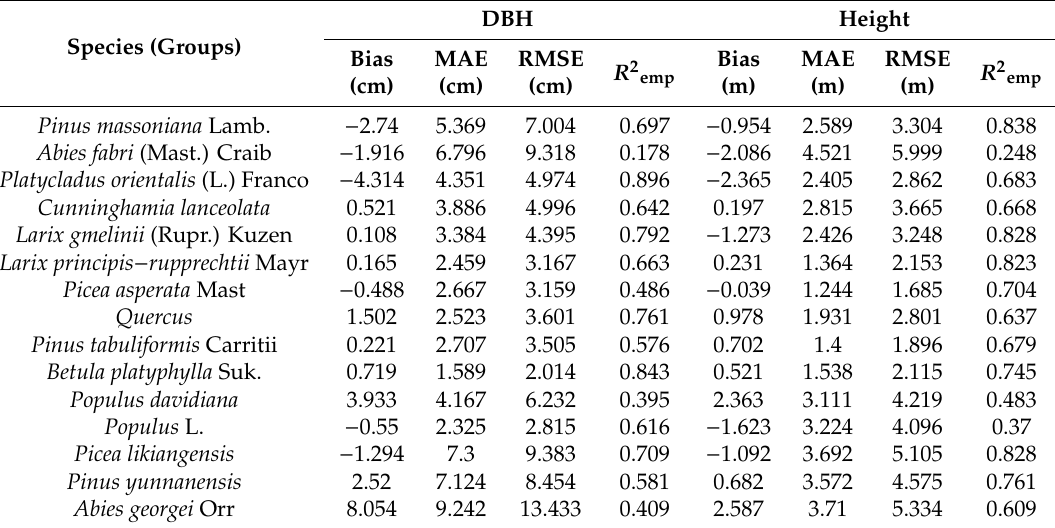
Table A6. Validation precision of Richards (1959) model for di ff erent tree species.